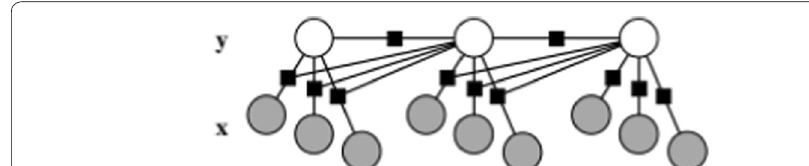
Fig. 2 CRF-transitional states depend on current observation [23]